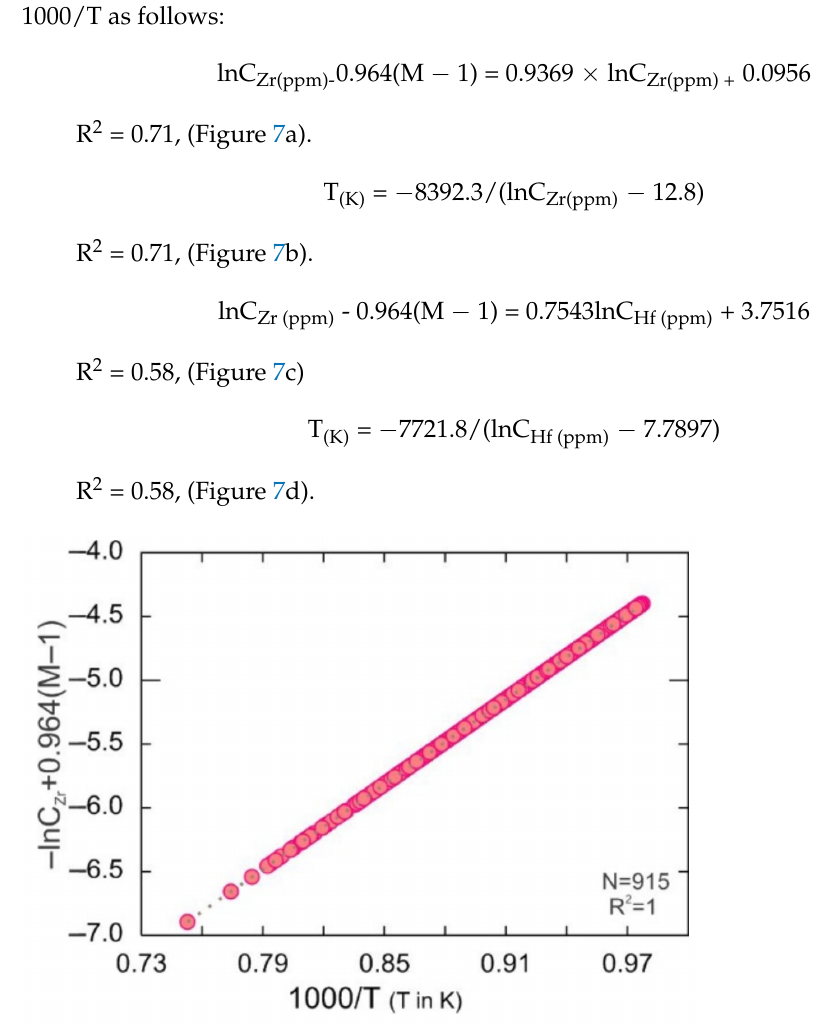
Figure 6. Variation of − lnC Zr + 0.964(M − 1) vs. 1000/T (T K ) to refine the zircon saturation for metaluminous to peraluminous rocks which are modeled by the equation of